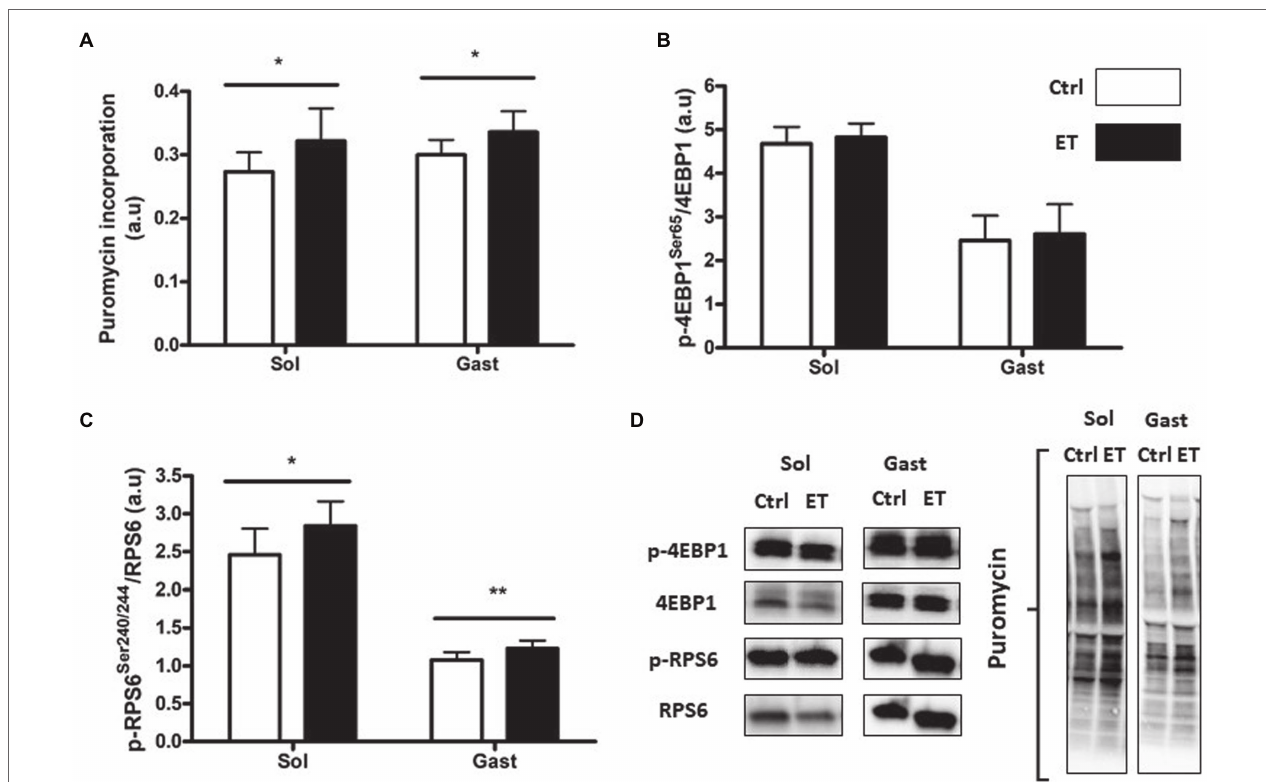
FIGURE 3 | Ergothioneine effect on protein synthesis markers at 2 h post-exercise. Evaluation of puromycin incorporation and protein synthesis marker expression in soleus ( n = 2/mouse) and gastrocnemius ( n = 1/mouse) samples. (A) Quantification of protein synthesis by measuring puromycin incorporation in